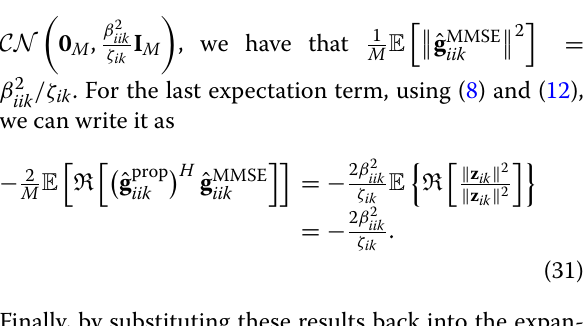
Figueiredo etal. EURASIPJournalonWirelessCommunicationsandNetworking (2018)